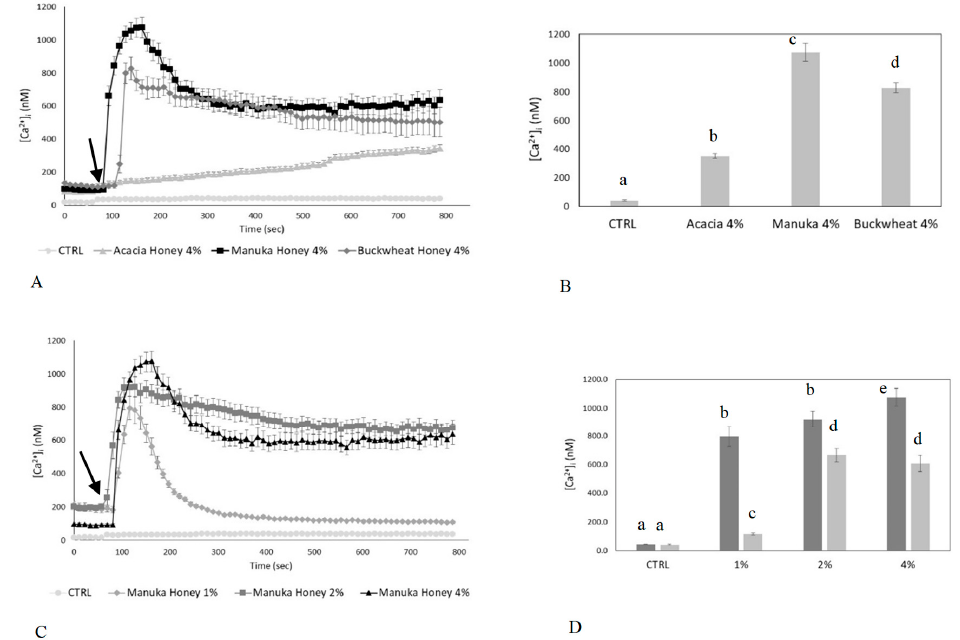
Figure 1. Honey induces an increase in intracellular Ca 2+ concentration in human keratinocytes. ( A ) [Ca 2+ ] i variations recorded at 10-s intervals, showing no variations in control conditions, and distinct patterns of Ca 2+ signaling after exposure to different Honey samples (i.e., Acacia, Manuka, Buckwheat 4% v / v ). The arrow indicates the addition of different honey types after 60 s. Data are presented as means ± SEM. of [Ca 2+ ] i traces recorded in different cells. Number of cells: CTRL: 20 cells from 2 experiments (exp); acacia honey: 40 cells from 3 exp; manuka honey: 30 cells from 3 exp; buckwheat honey: 40 cells from 3 exp. ( B ) Mean ± SEM of the peak Ca 2+ response induced by treatment with